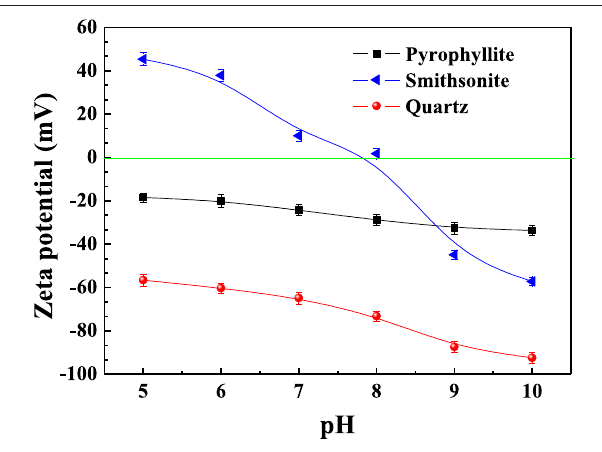
FIGURE 4 | Flotation index of the froth with different collectors (pH 6.0, NaOL, and DDA 2 × 10 – 4 M, PNP 1 g/L). FIGURE5| EffectofpHonthezetapotentialofpyrophyllite,smithsonite,